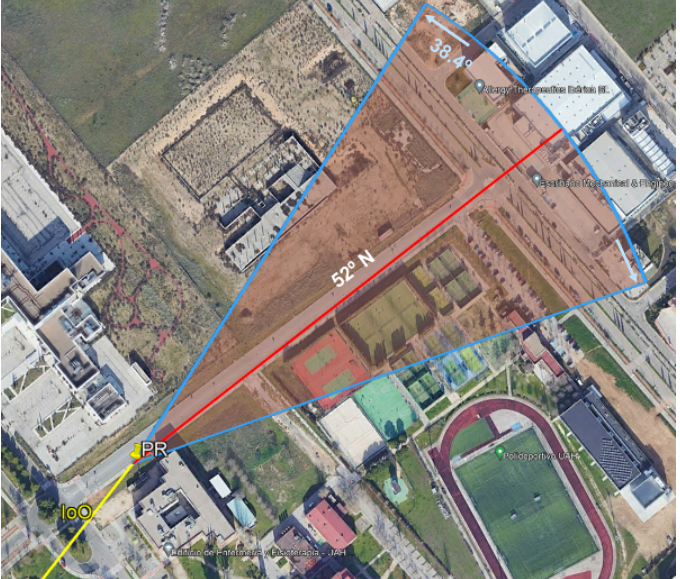
Figure 10. Semi-urban scenario for trials located in the external campus of University of